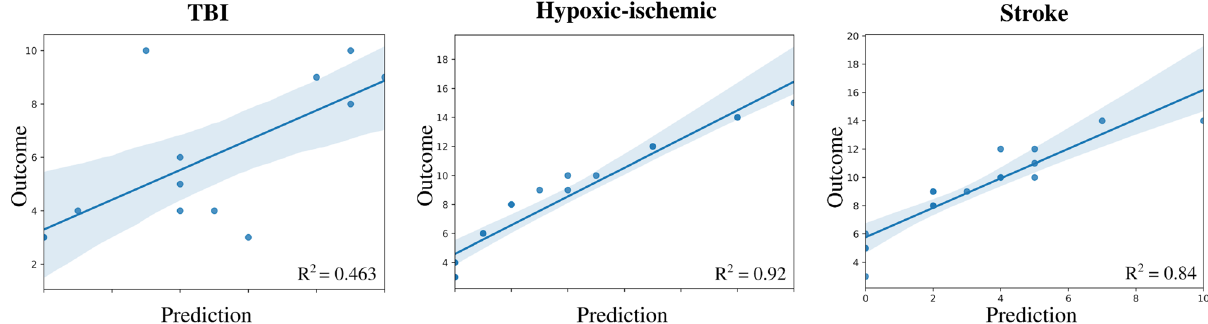
Figure 4. Multivariate analysis for prediction of outcomes of consciousness by etiology. In the three scenarios (traumatic brain injury, cardiac arrest, and stroke), the outcome for each patient is demonstrated by a linear model. The curves show a direct correlation between imaging and prediction of consciousness outcome, with corresponding R 2 values of 0.463, 0.92 and 0,84,